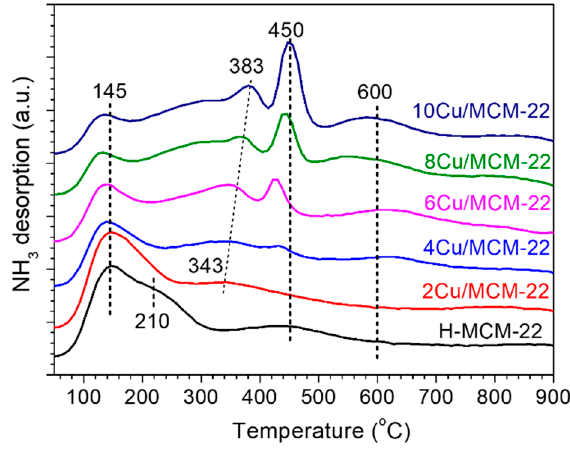
Figure 3. NH 3 -TPD profiles of H-MCM-22 and x Cu/MCM-22 zeolites.